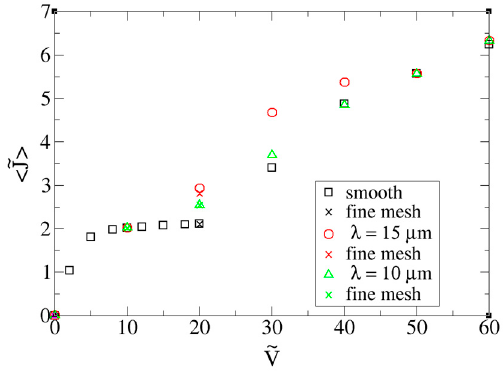
Figure 11. Baseline 2-D case. Time- and area-averaged current density.